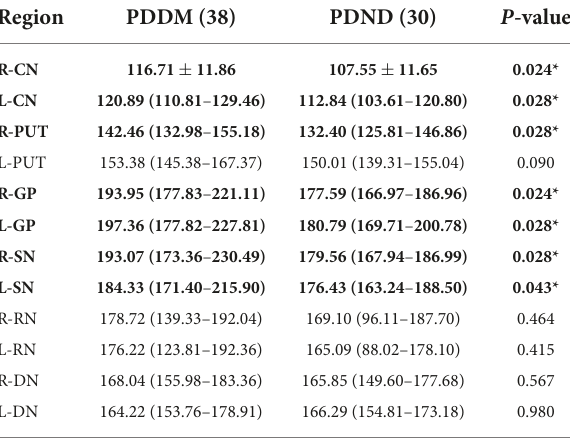
TABLE 4 MSV RII of gray matter nucleus between PDDM group and PDND group.